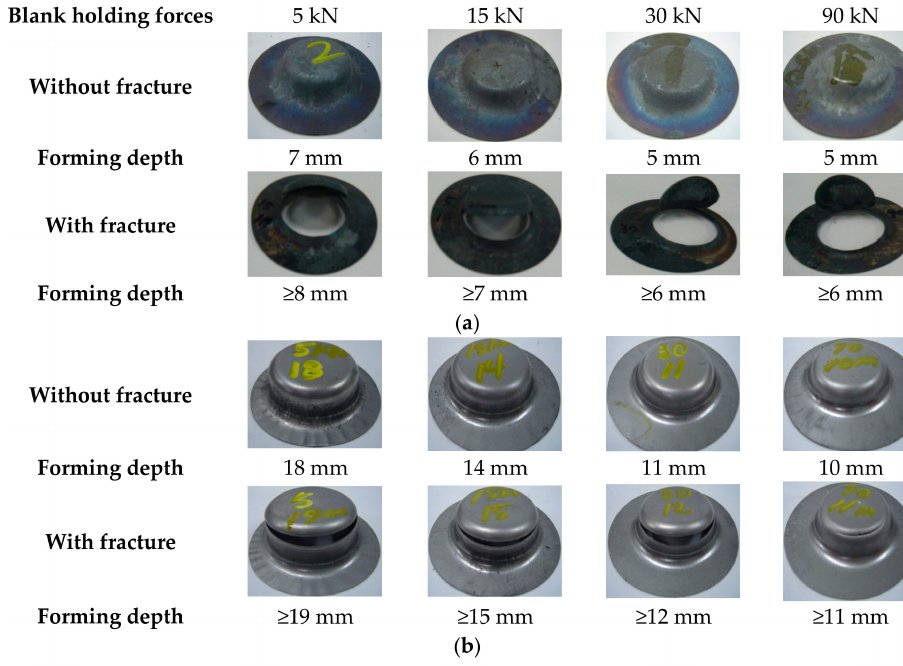
Figure 6. Shape of drawn cups without fracture and with fracture at different blank holding forces: ( a ) direct deep drawing ( T s = 950 ◦ C); ( b ) indirect deep drawing ( T s =